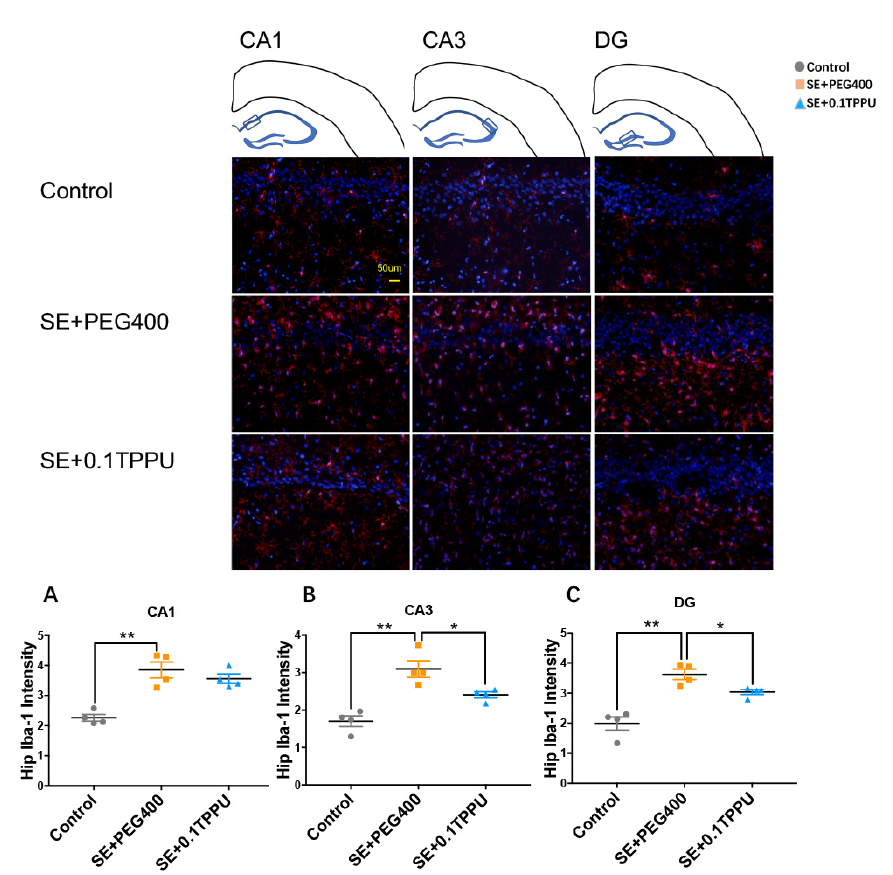
Figure 3. ( A ) The Iba-1 intensity in CA1 subarea was significantly increased in SE+PEG400 group compared with Control group. ( B , C ) The Iba-1 intensity in CA3 and DG subareas was significantly increased in SE+PEG400 group compared with Control group, which was significantly decreased in SE+0.1TPPU group (Figure 3A–C, one-way ANOVA test, * p < 0.05, ** p < 0.01 n = 4). CA, Cornu Ammonis; DG, dentate gyrus; Hip, hippocampus. Iba-1, ionized calcium binding adaptor molecule-1.